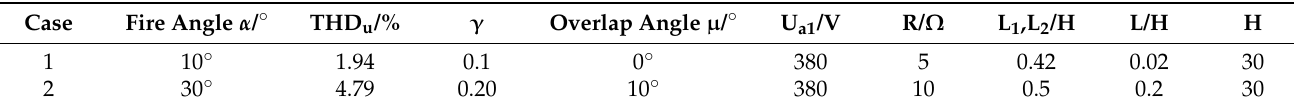
Table 1. Simulation parameters of 12-pulse